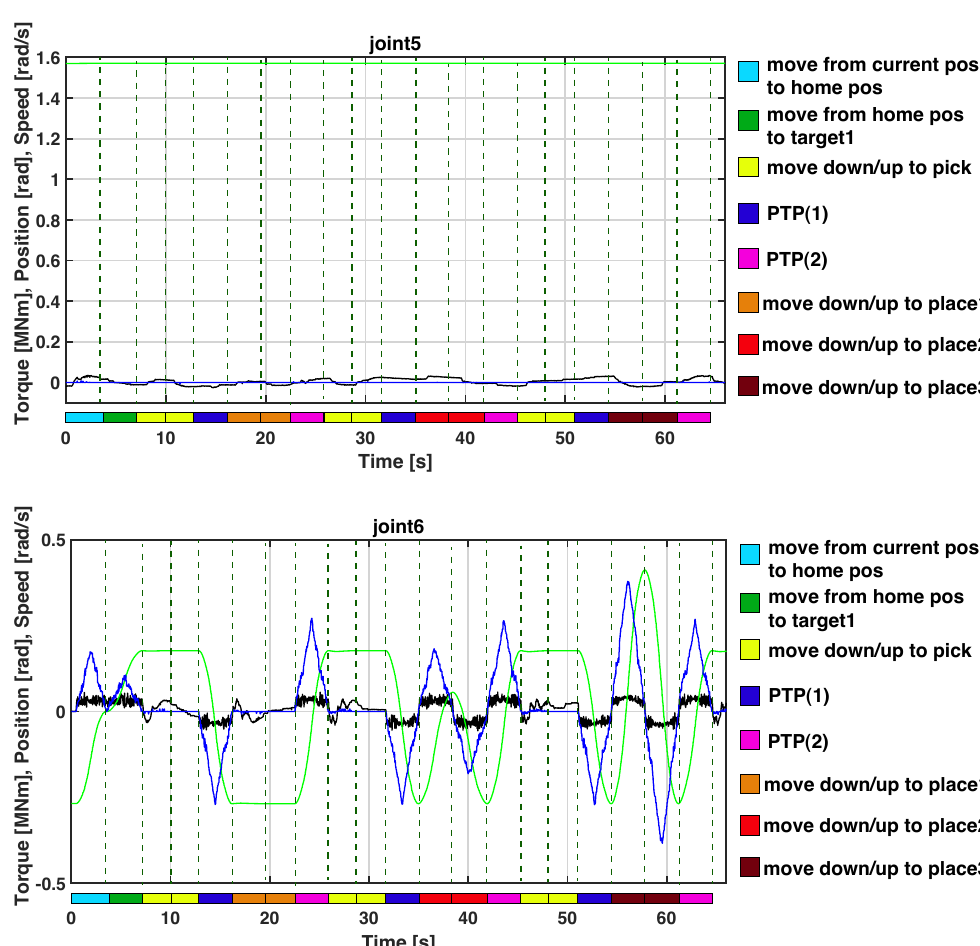
Figure 10. Fourth, fifth, and sixth joints’ torque (in black), speed (in blue), and position (in green) acquired at 40 Hz for the 68.75 section (2750 samples each) during the execution of the palletizing program. The colors below the graph’s x axis represent the motion commands executed during the acquisition.